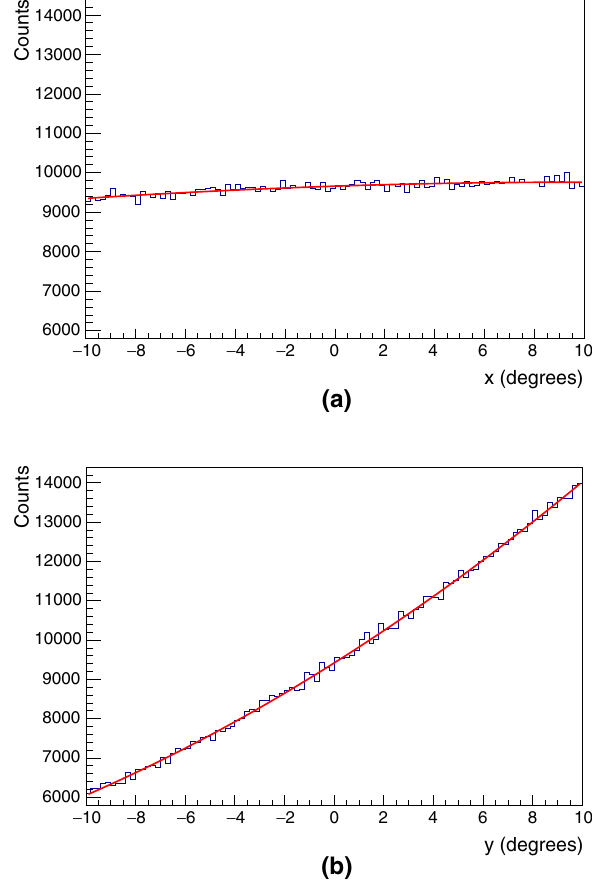
Fig. 4 Projection of the measured 2-D event distributions, in absence of the Moon shadow ( H 0 ), for the field of view coordinates x = (α μ − α ) × cos h μ and y = h μ − h Moon